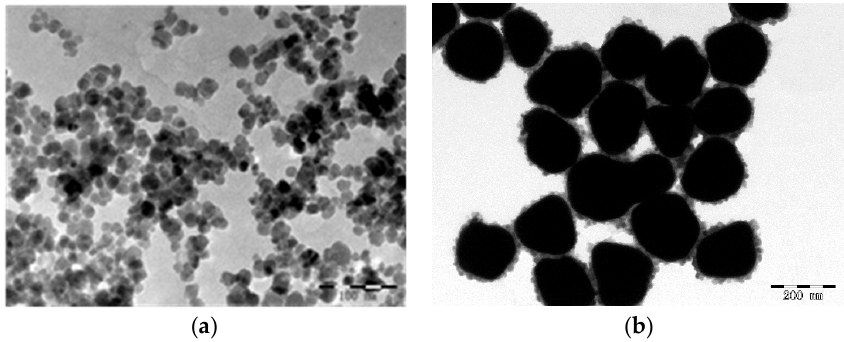
Figure 2. TEM images of magnetic nanoparticles ( a ) and gold-magnetic nanoparticles ( b ).